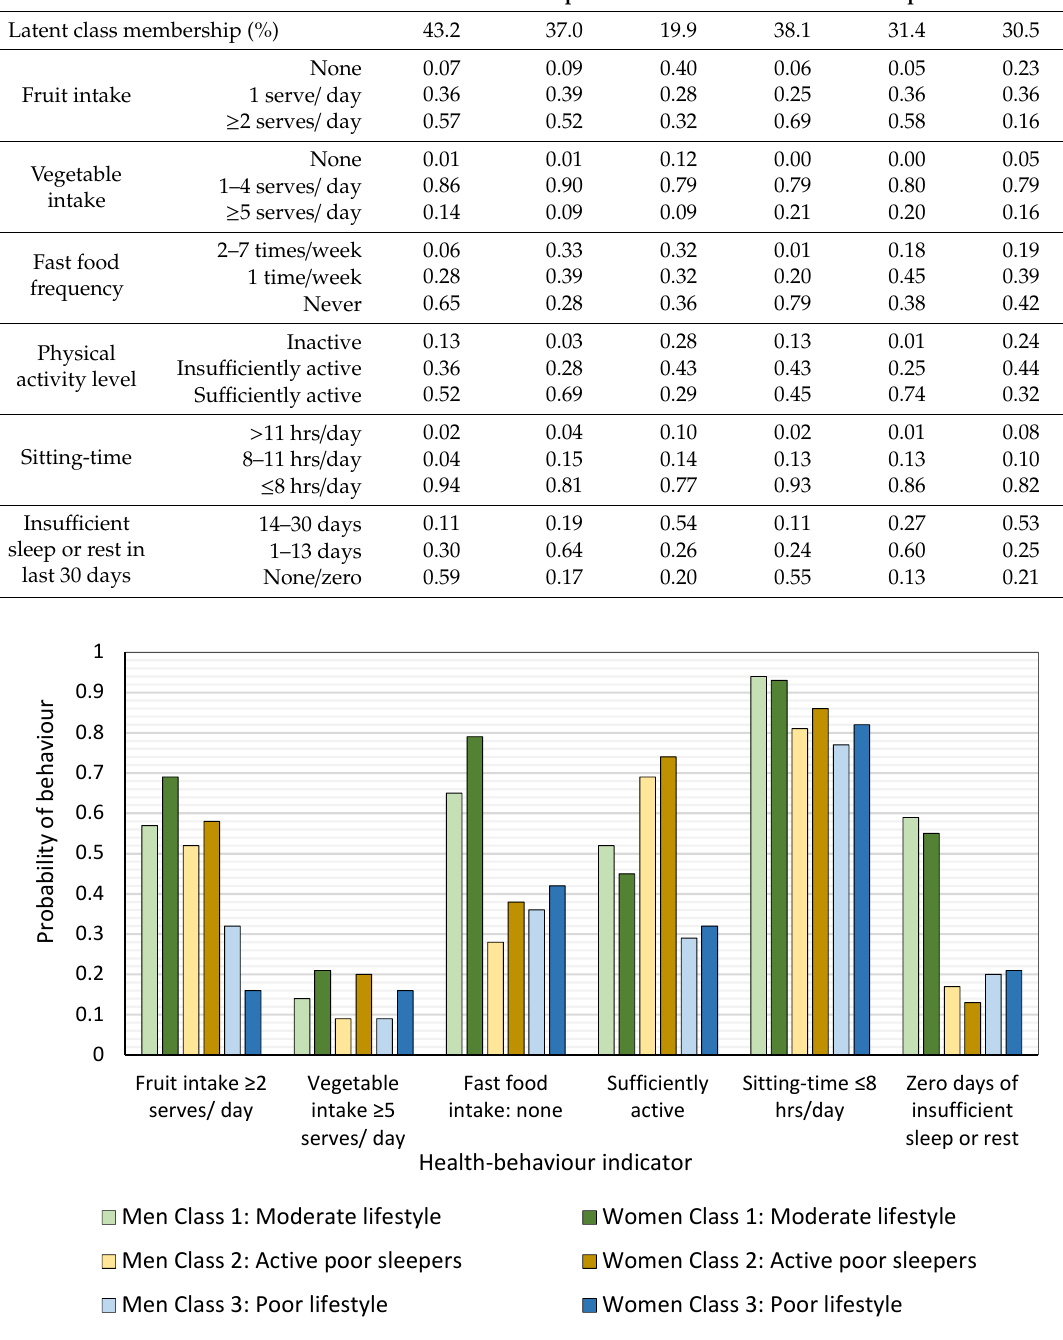
Table 2. Latent class analysis by sex, item-response probabilities for health behaviour indicators (n = 3374).